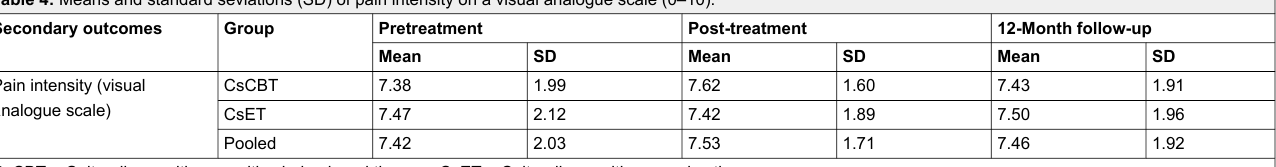
Table 4: Means and standard seviations (SD) of pain intensity on a visual analogue scale (0–10).